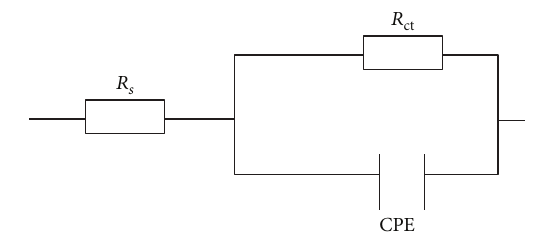
Figure 12: Equivalent circuit model for fitting impedance